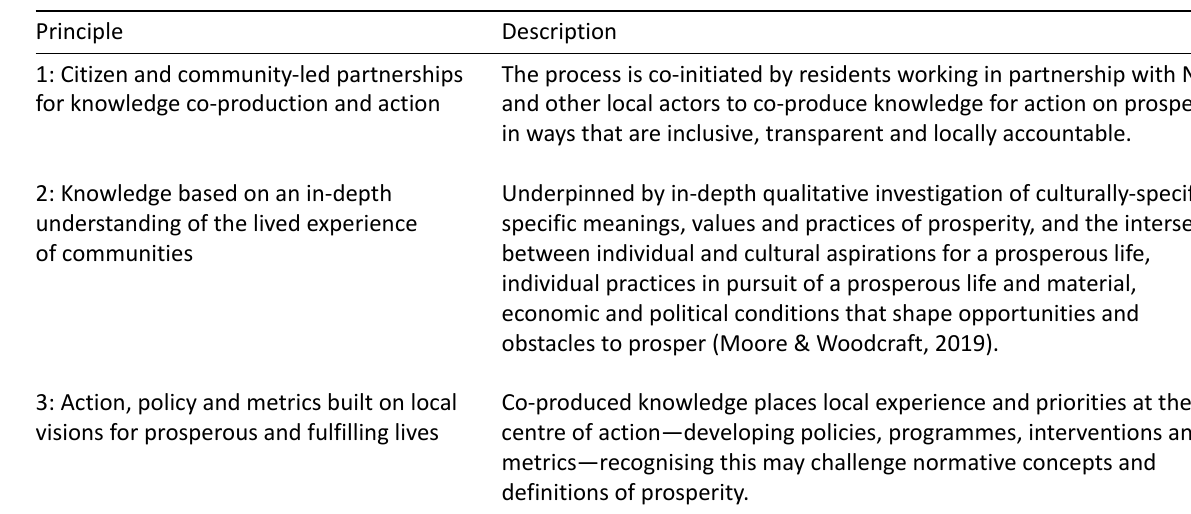
Table 1. Prosperity Index